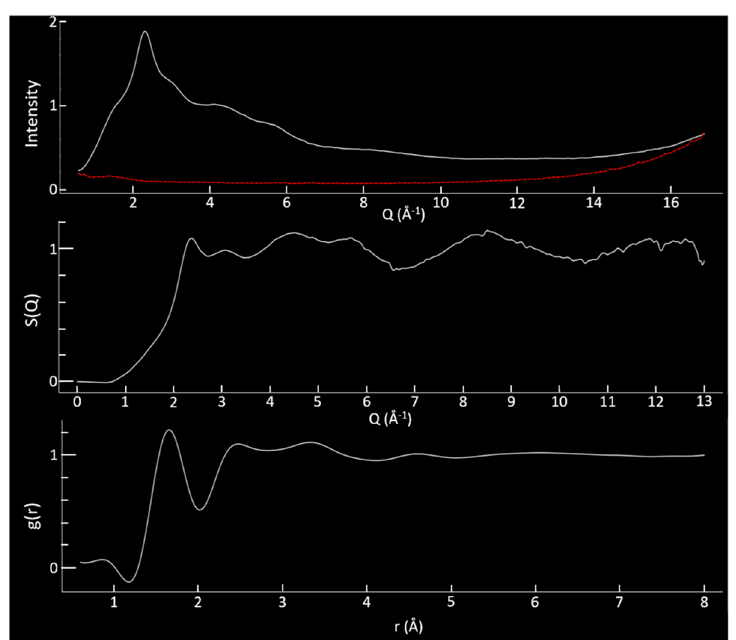
Figure 8. A captured screenshot of the data analysis software “Glassure”. The top window shows the collected sodium silicate liquid data at 3 ± 0.1 GPa and 1673 ± 90 K. The red dotted line in the top window is the background collected using an empty cell assembly at ambient condition. The middle window shows the structure factor S(Q) of the liquid sample. The signal becomes noisy at Q > 12 Å − 1 . The bottom window is the pair distribution function of the liquid sample with a Max Q cutoff of the structure factor at 13 Å − 1 . We are currently working on data collection of sodium silicate liquids at higher pressures; detailed analysis will be published in the future.